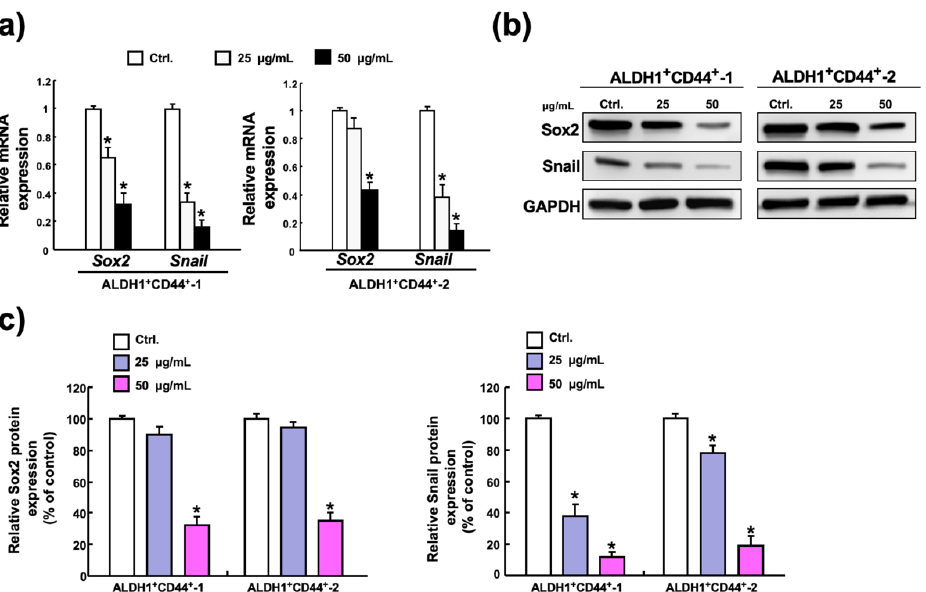
Figure 5. Administration of butylidenephthalide represses the expression of Sox2 and Snail. ( a ) Gene and ( b ) protein expression levels of stemness marker Sox2 and EMT marker Snail were both downregulated in the ALDH1 + /CD44 + cells following treatment at various concentrations of butyli- denephthalide. ( c ) The relative level of indicated protein expression was measured by densitometer and normalized against GAPDH. The control was set as 100%. Optical density values represent the mean ± SD of three independent experiments; * p < 0.05 compared to Ctrl (control group containing 0.1% DMSO without butylidenephthalide).